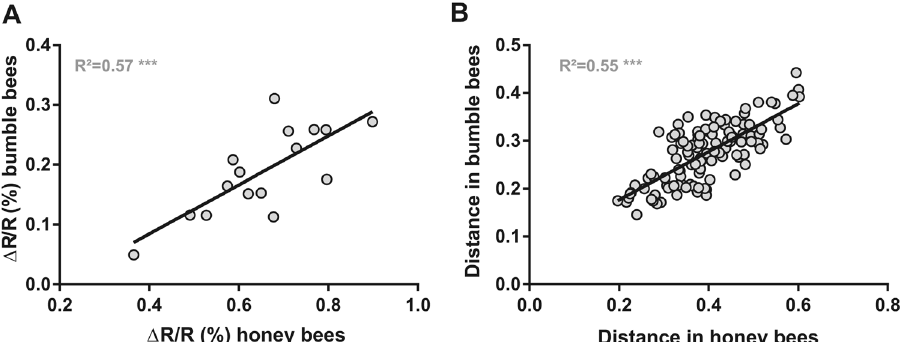
Figure 7. Comparison of odor coding in bumble bee and honey bee AL. ( A ) Correlation of response intensity for each of the 16 presented odorants between bumble bee (n = 14) and honey bee (n = 10) measures. A high and significant correlation is observed (R 2 = 0.57, p < 0.001). ( B ) Correlation of Euclidian distances between odor response maps for the 120 odorant pairs obtained in bumble bees and honey bees. A high and significant correlation is also observed (R 2 = 0.55, p < 0.001). Honey bee data from 38